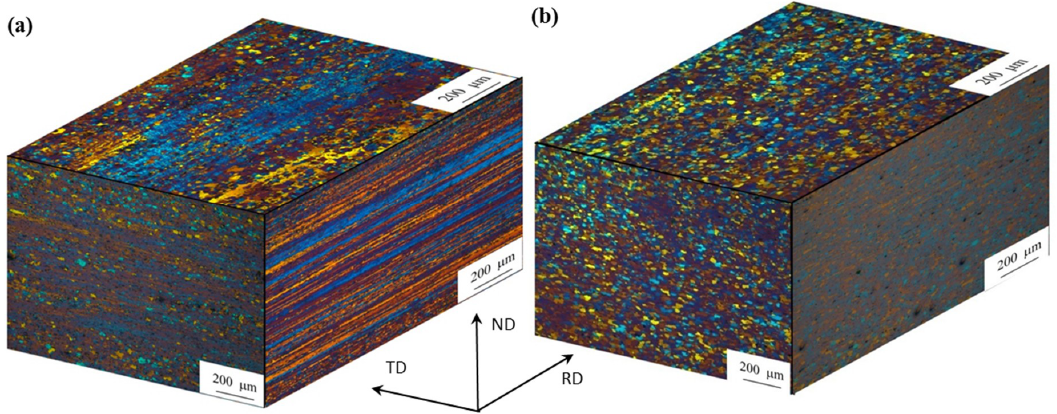
Figure 11. Tensile properties and fracture toughness of the experimental alloys after solution and aging treatment (520 ° C/1 h and 180 ° C/22 h).